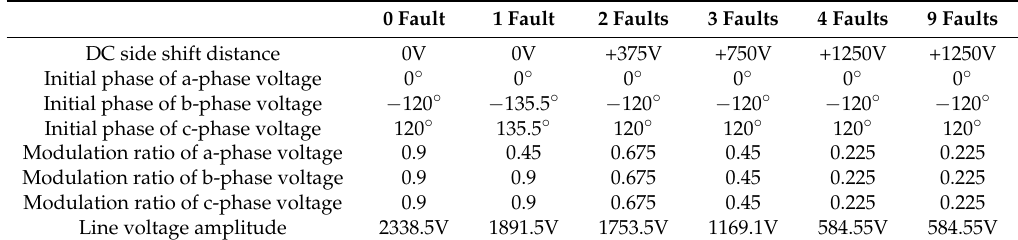
Table 2. The fault-tolerant reconstruction parameters in each